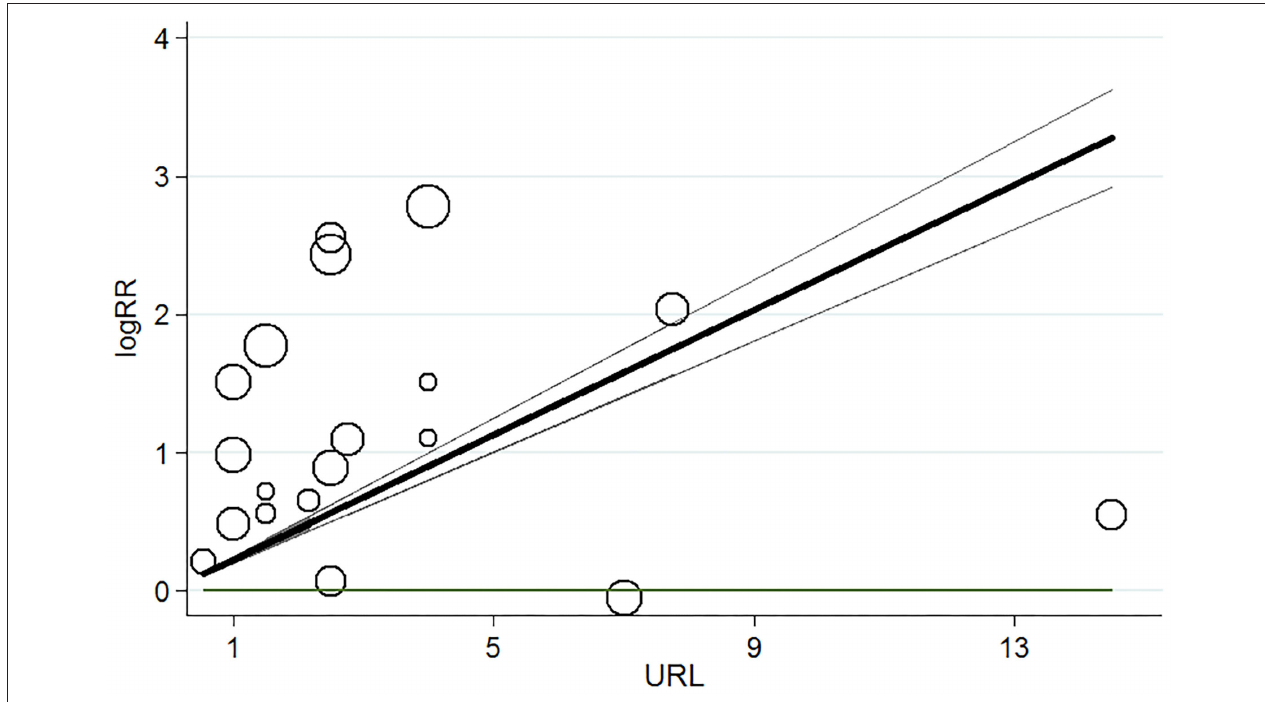
FIGURE 3 | Dose–response relationship for myocardial injury and risk of short-term all-cause mortality in patients with COVID-19. Each black small circle indicates logOR for each category of cardiac troponin levels which is proportional to its statistical weight; solid line represents weighted logOR, and it is two accompanying dashed lines represent its lower and upper CIs. Horizonal solid line indicates the null hypothesis (logOR = 0). CI, confidence interval; OR, odds